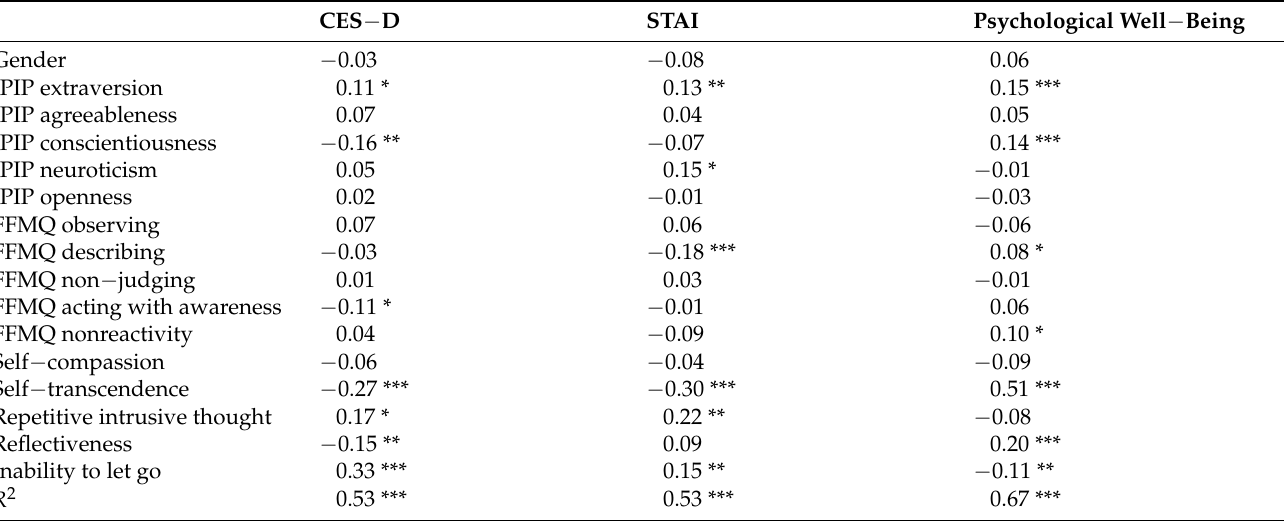
Table 7. Results from multiple regression analyses predicting dysphoria (CES-D), anxiety (STAI), and psychological well-being (PWB) from gender, the Big Five, the mindfulness variables, repetitive intrusive thought, reflectiveness, and the inability to let go in Sample 2. All regression coefficients are beta coefficients (i.e., standardized